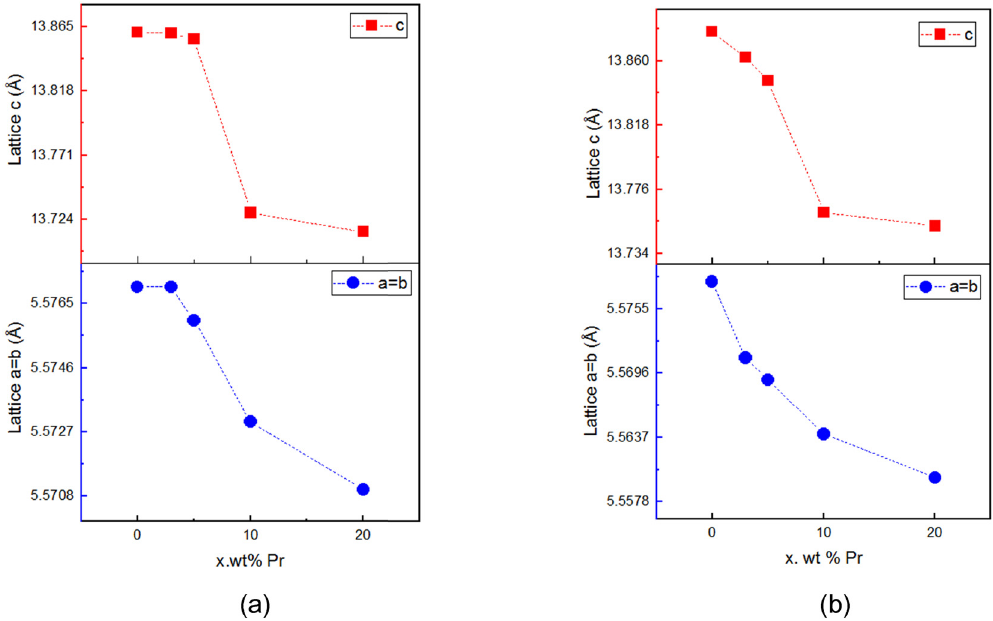
Figure 2: Lattice constants of BiFeO 3 and Bi 1 − x Pr x FeO 3 fi lms using ( a ) GSAS re fi nement and ( b ) manual